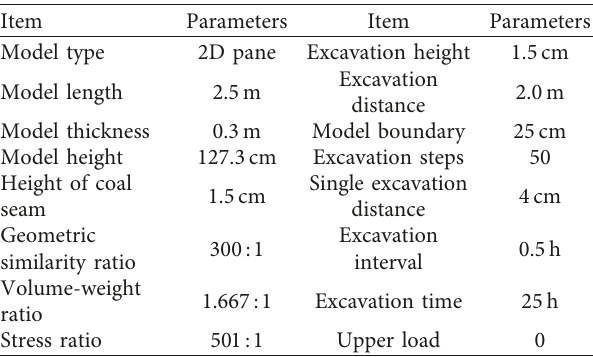
Figure 8: Main roof suspension state above the coal pillar after No. 11213 working face. Table 2: Basic parameter table for physical similarity